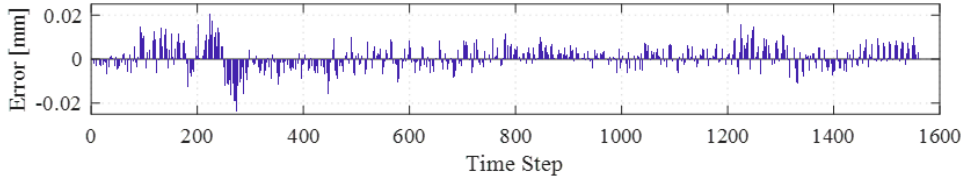
Figure 23. Di ff erence between the exact displacement and prediction calculated at each time step for Model 1b without specimen.